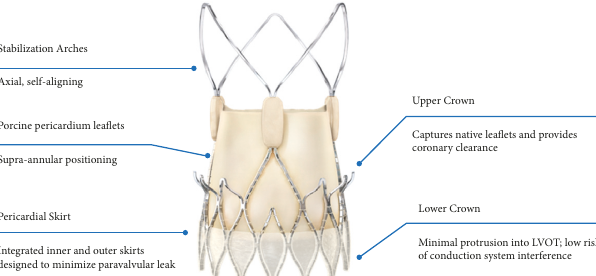
Figure 1: The ACURATE neo valve. The ACURATE neo valve is comprised of three porcine pericardial leaflets sewn into a self-expanding nitinol frame with three axial stabilization arches. The supra-annular positioning contributes to low gradients. The pericardial skirt is designed to minimize paravalvular